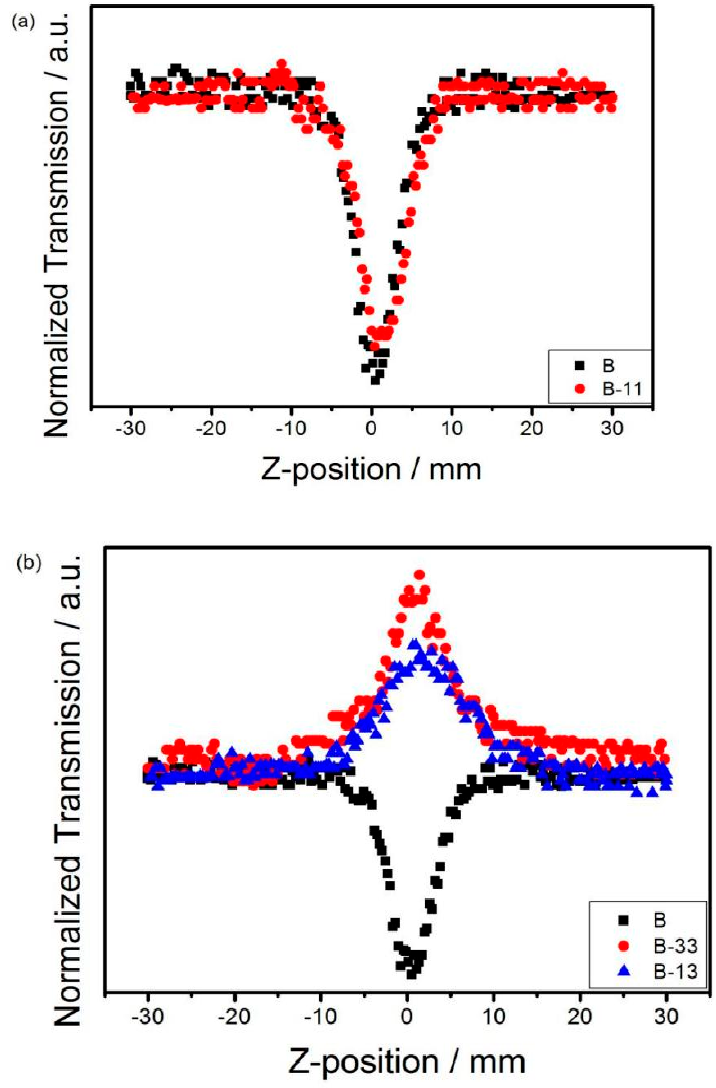
Figure 5. Regularized locked ori fi ce Z − scan traces of the compounds ( a ) B and B − 11; ( b ) B and B − 33, B − 13. B-33 , B-13